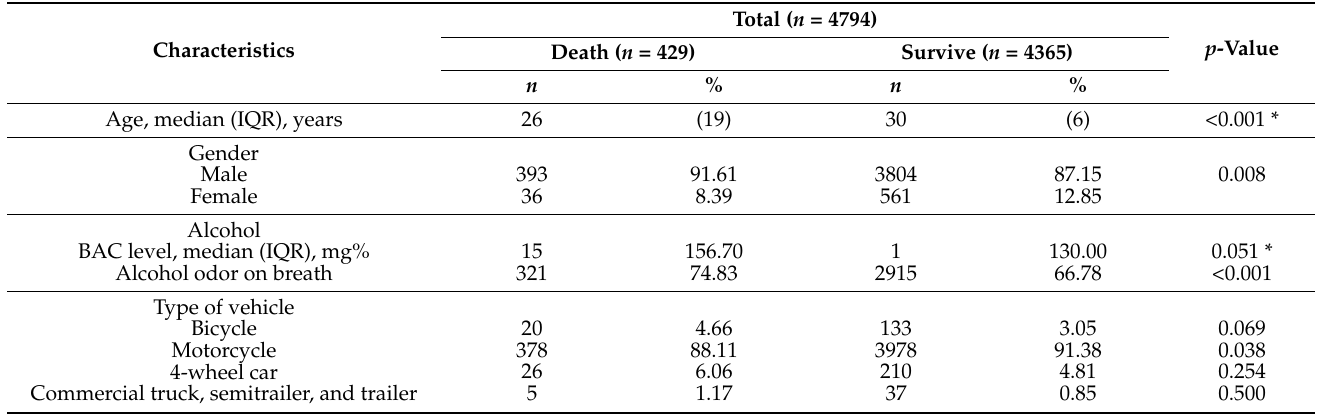
Table 1. Baseline driver characteristics divided by the target